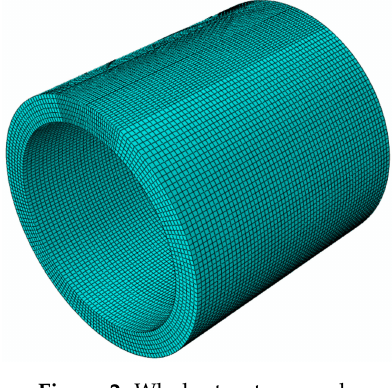
Figure 2. Whole structure mesh. Table 1. Properties of materials used in the numerical analysis